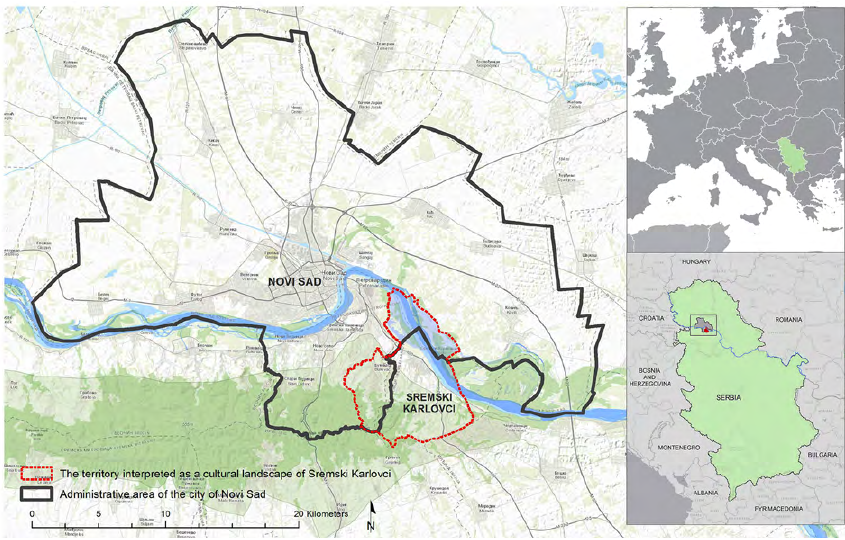
Figure 1. The position of Sremski Karlovci in the regional context. Basemap source: ESRI World Topographic Map [click on figure to